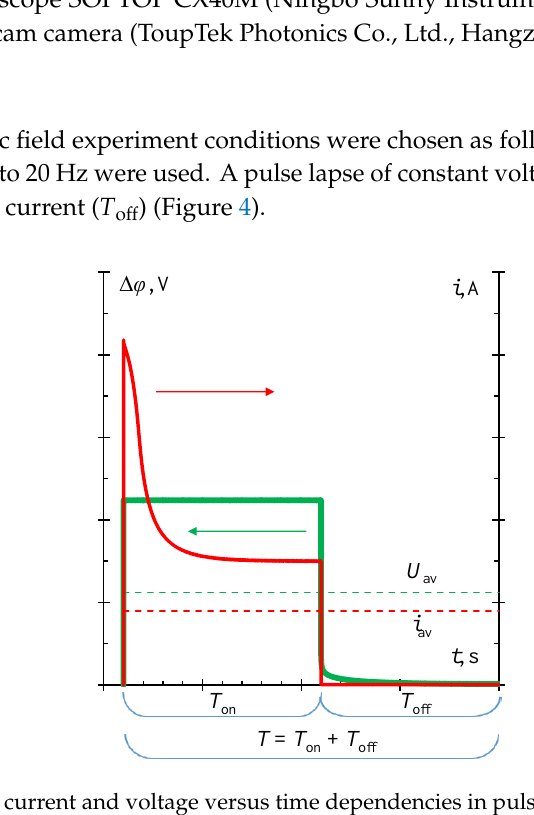
Figure 4. Schematic current and voltage versus time dependencies in pulsed electric field mode. The dashed lines show the period-averaged applied potential ( U av ) and the period-averaged measured current ( i av )